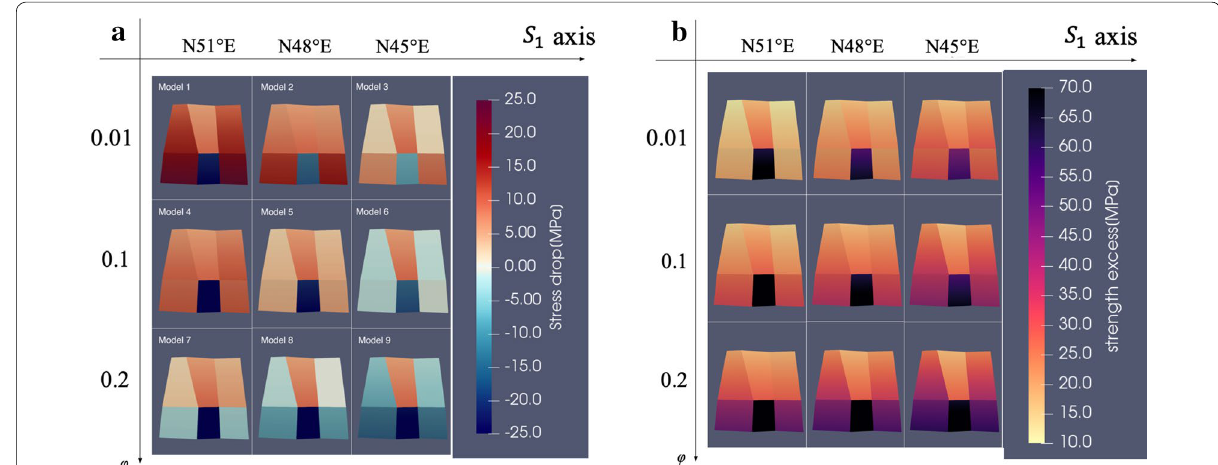
Fig. 4 On-fault distributions of potential stress drop ( a ) and strength excess distribution ( b ) for different values of stress ratio ϕ and maximum principal stress